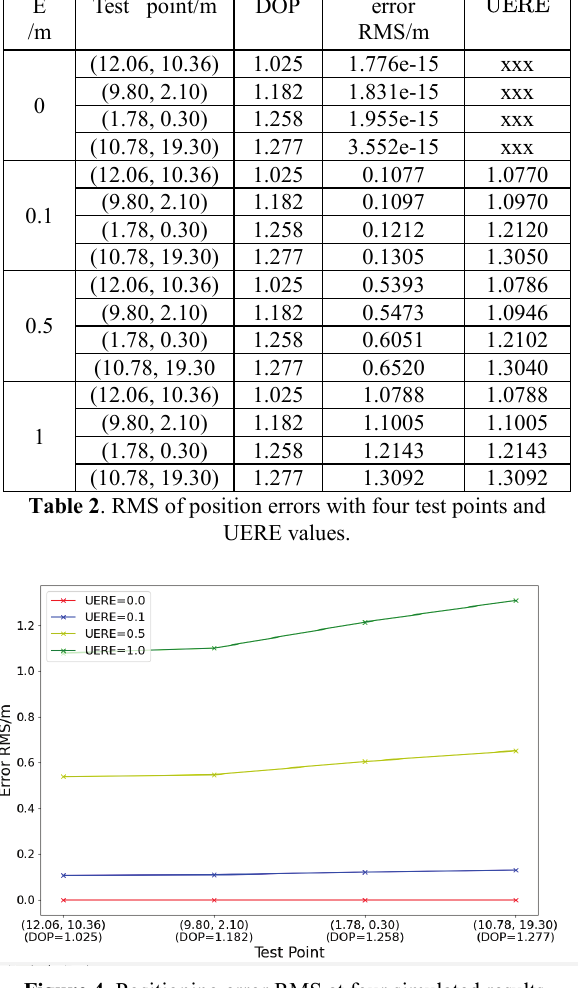
Figure 4 . Positioning error RMS at four simulated